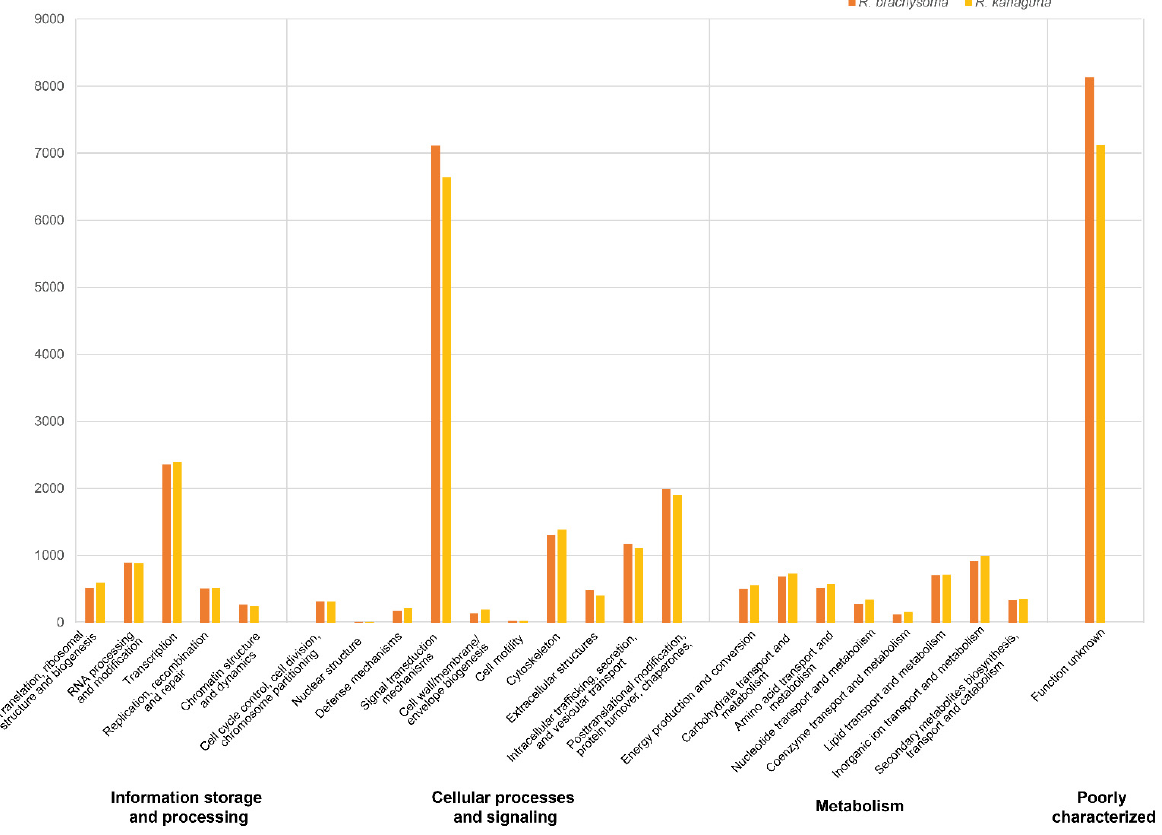
Figure 4. Classification of Eukaryotic Orthologous Groups (KOGs) in gene prediction. Orange bars represent the KOGs of R. brachysoma and yellow bars the KOGs of R. kanagurta . KOG categories appear on the horizontal axis, and the frequencies of the categories are indicated along the vertical axis.